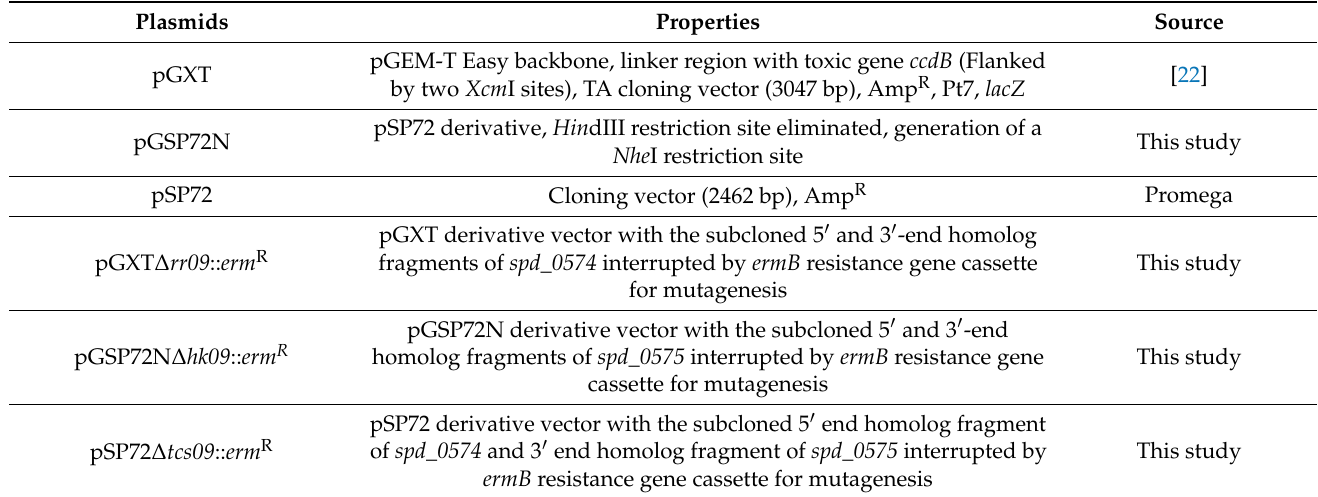
Table 3. Plasmids used for